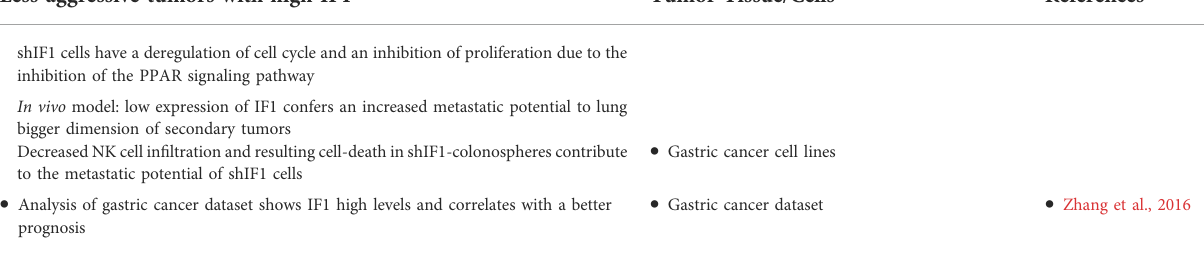
In vivo model: low expression of IF1 confers an increased metastatic potential to lung bigger dimension of secondary tumors DecreasedNKcellin fi ltrationandresultingcell-deathinshIF1-colonospherescontribute to the metastatic potential of shIF1